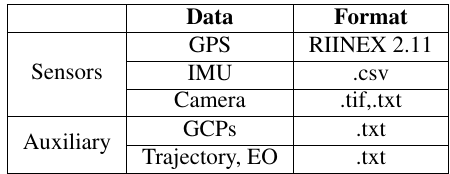
Table 8. Summary of the data formats in the